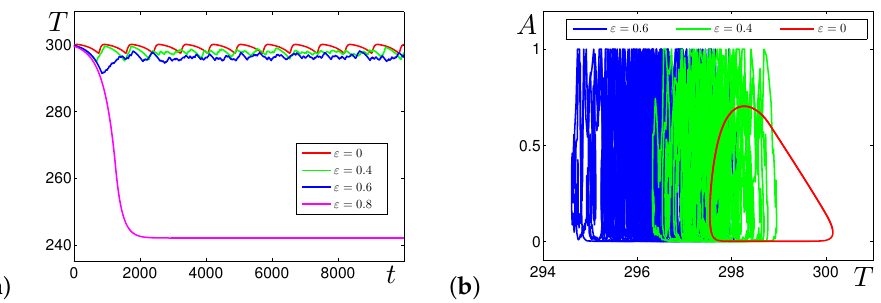
Figure 5. Stochastic system (2), (3) for γ = 0.02, σ 1 = 1, σ 2 = 0: ( a ) time series, ( b ) phase trajectories.